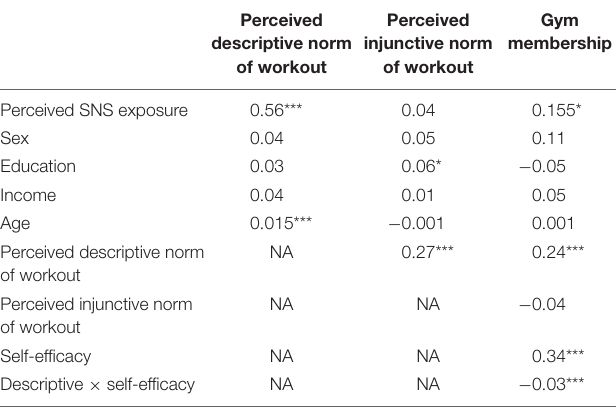
perceived descriptive norm and perceived injunctive norm moderated by self-efficacy.